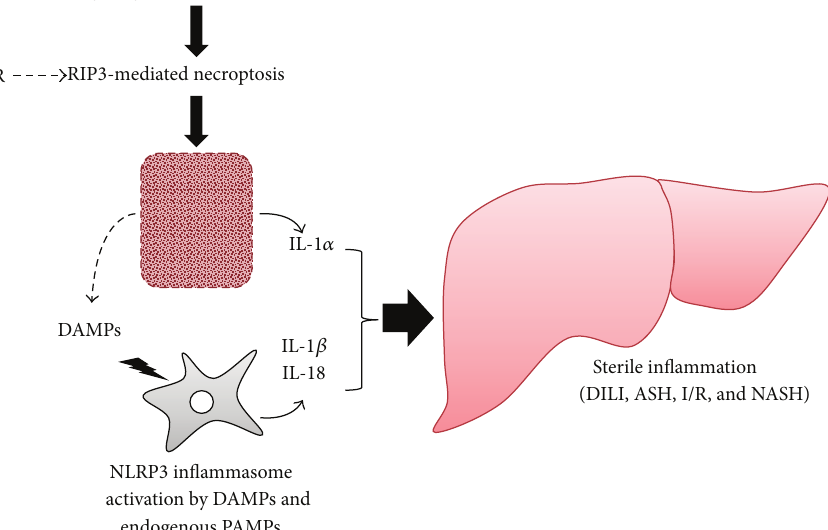
Figure 4: Mechanisms for IL-1-mediated liver diseases. Intake of acetaminophen, alcohol, or perhaps diet induces necroptosis of hepatocytes via activation of RIP3. Ischemia-reperfusion also causes RIP3-mediated hepatocyte necroptosis. Necroptotic hepatocytes release their cellular contents, including IL-1 𝛼 and DAMPs. DAMPs such as saturated FFAs, which are metabolites of high-calorie diets, and endogenous PAMPs, such as LPS translocated from the gut microbiome, can activate NLRP3 inflammasomes to release IL-1 𝛽 . In turn, IL-1 𝛽 and IL-1 𝛼 exacerbate the liver inflammation and injury. This inflammation-amplifying mechanism is known as “sterile inflammation,” given the absence of exogenous microbes or their PAMP products. In contrast, IL-18 regulates NASH via maintenance of healthy intestinal microbiota. APAP: acetaminophen; ASH: alcoholic induced steatohepatitis; DAMPs: damage-associated molecular patterns; DILI: drug-induced liver injury; I/R: ischemia-reperfusion injury; NASH: nonalcoholic steatohepatitis; NLRP3: NACHT, leucine-rich repeat, and pyrin domain-containing protein-3; PAMPs: pathogen-associated molecular patterns; RIP3: receptor interacting protein